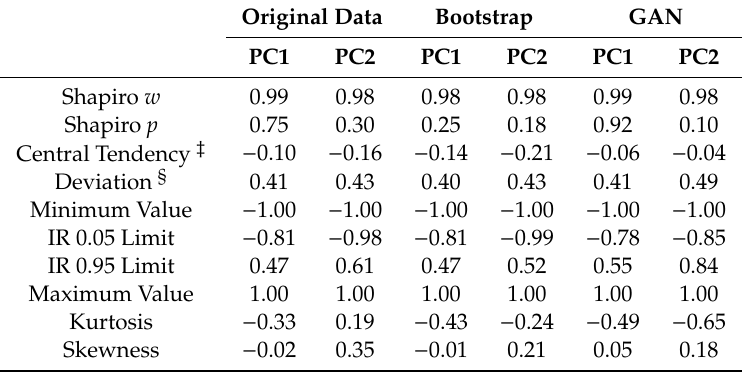
Figure 8. Histograms and scatter plots of augmented DS3 using bootstrap and GAN. New points are marked in red. Table 7. Comparison of descriptive statistics obtained when comparing traditional bootstrapping procedures for numeric data augmentation and the best performing GAN on DS3. Dataset was augmented to size 100.